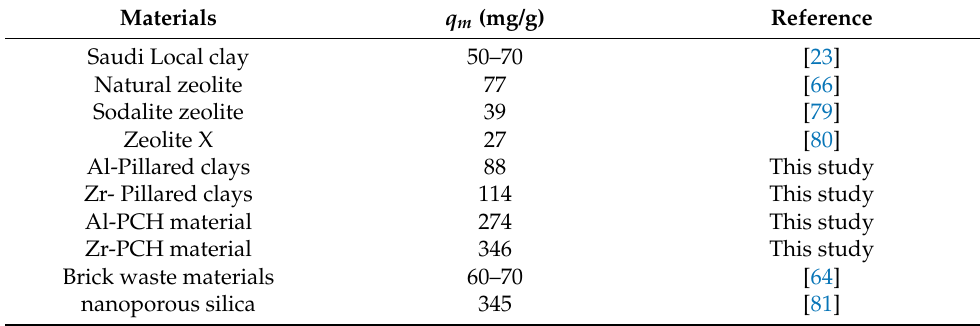
Table 4. Removal properties of selected